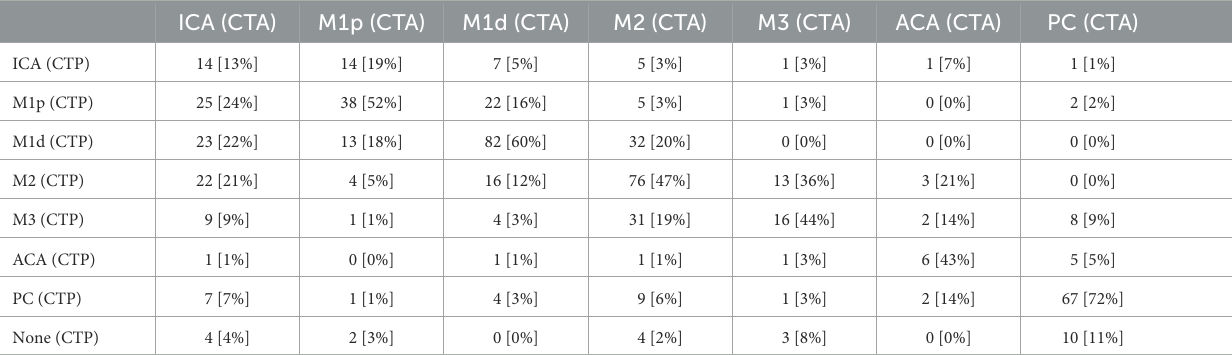
TABLE 2 The confusion matrix for the annotated vessel occlusion locations from CT angiography (CTA) and the indicated vessel occlusion locations from CT perfusion (CTP).